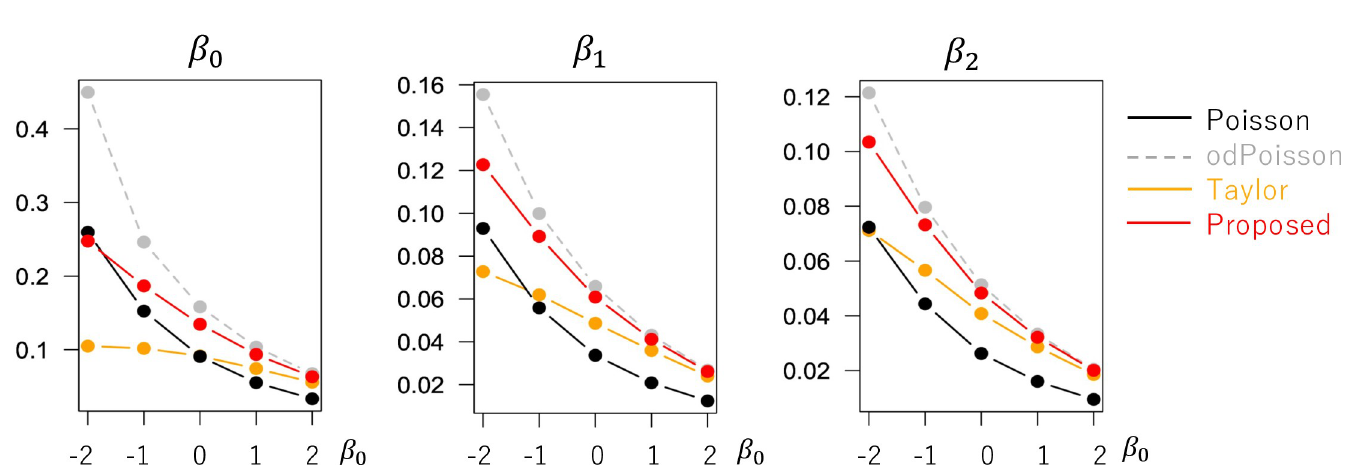
Fig 9. Means of the coefficient standard errors ( N = 200) (x − axis: β 0 , y-axis: mean standard error).